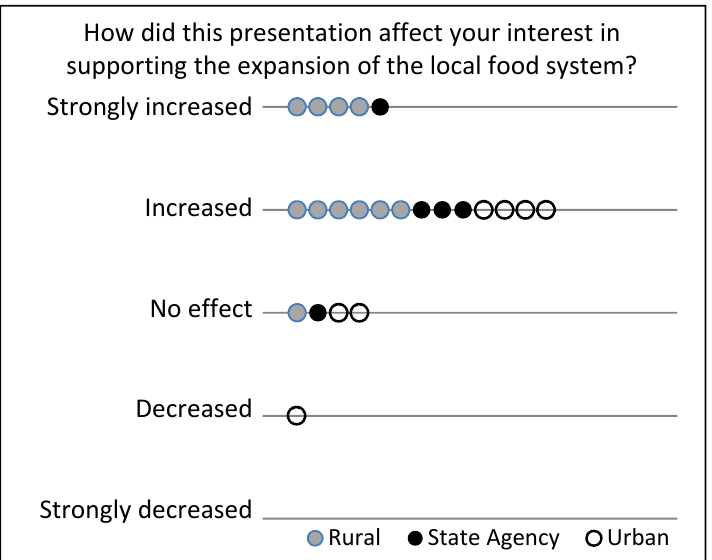
Figure 3. Responses to Survey Question Regarding the Presentation’s Effect on Interest in Supporting the Local Food System Most respondents reported hearing the economic impact findings increased their interest in supporting local food